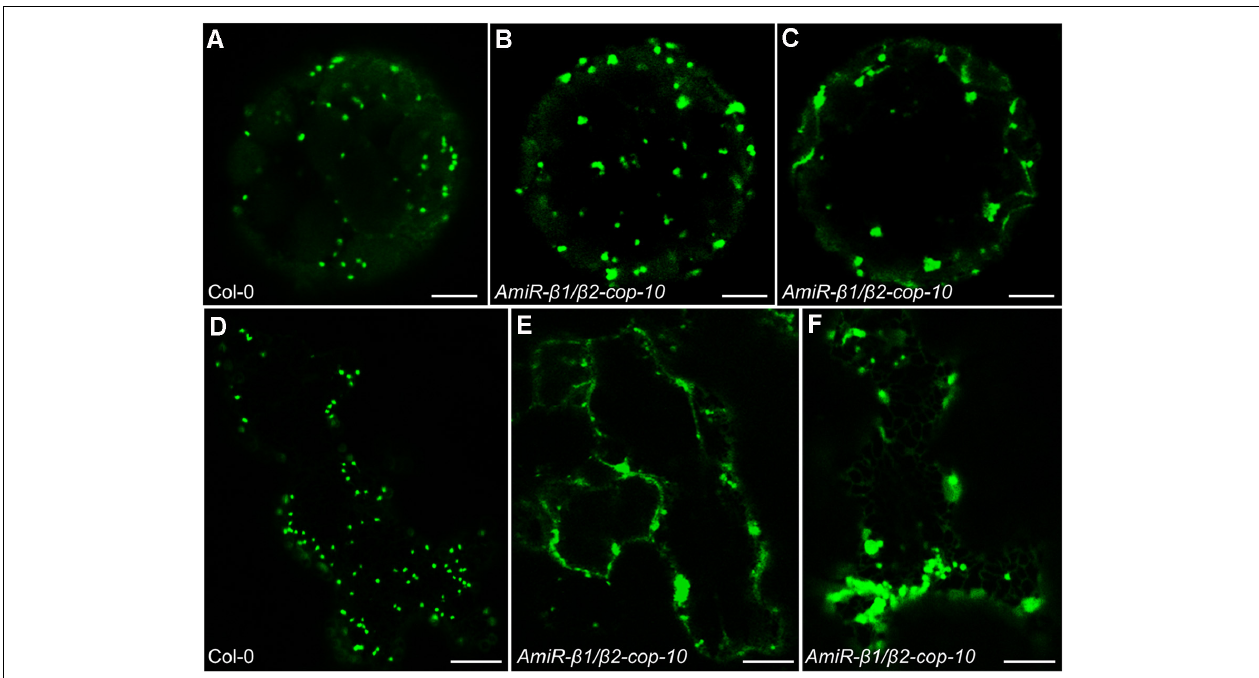
FIGURE 6 | Localization of ManI-GFP in the amiR- β 1/ β 2-cop mutant. (A–C) Transient gene expression of ManI-GFP in Arabidopsis protoplasts obtained from wild type (Col-0) or amiR- β 1/ β 2-cop plants grown 4 weeks in soil. Scale bars: 5 µ m. (D–F) Transient gene expression of ManI-YFP in Arabidopsis seedlings of wild type (Col-0) or amiR- β 1/ β 2-cop . Scale bars: 10 µ m.